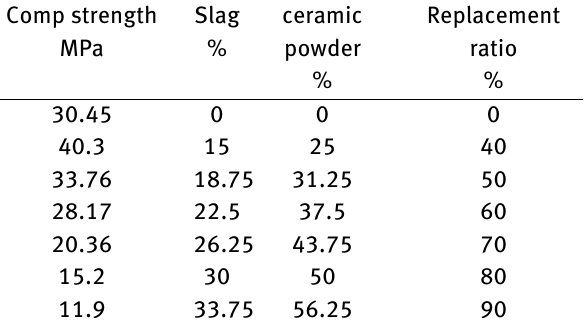
Table 12: Compressive strength of cubes (50 mm) replacement of